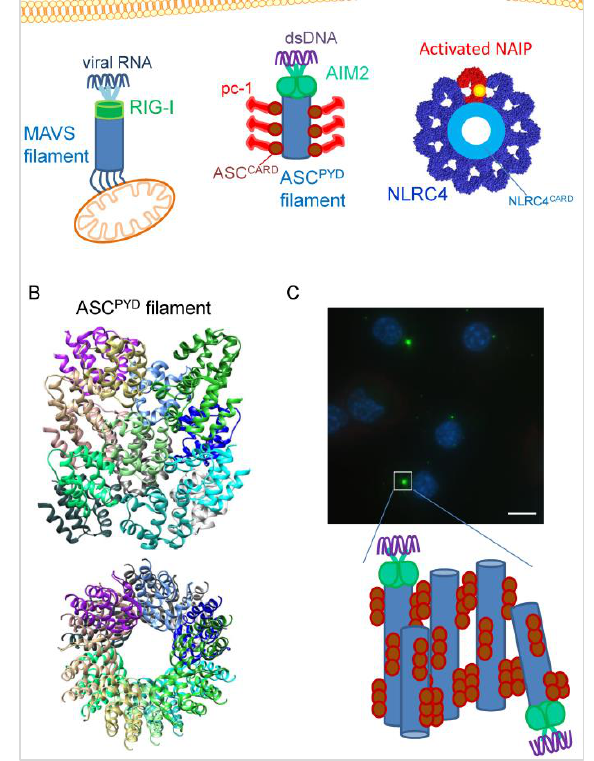
Figure 2: Innate immunity signalling platforms with a prionoid character. (A) The schematic representation of the assembly of RIG-I-nucleated MAVS filament (left), AIM2-nucleated ASC filament (middle), and NAIP-nucleated NLRC4 oligomer (right). In each case, nucleators are first activated by respective PAMP binding. The scheme of NLRC4 is based on the NLRC4 oligomer structure (PDB: 3JBL [85]). (B) The structure of ASC PYD filament as determined by electron microscopy (PDB: 3J63 [87]) reveals a hollow three-start helical assembly. (C) Upon activation of nucleators, ASC is re- cruited to perinuclear region to form ASC specks (immunofluorescence-labelled en- dogenous ASC specks are shown in green and nuclei are depicted in blue, bar repre- sents 10  m). Upon activation of PYD-containing receptors such as NLRP3 or AIM2, ASC specks are formed by the polymerisation of ASC PYD domains and crosslinking of ASC PYD filaments by ASC CARD domains [156]. Structural images were generated by use of UCSF Chimera